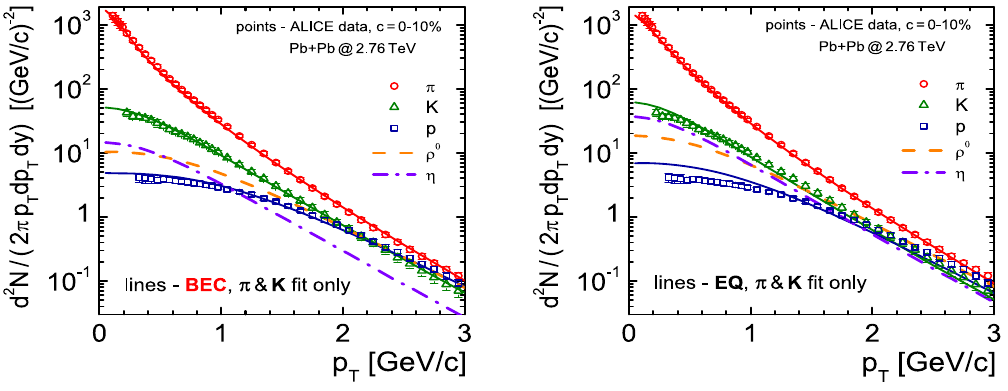
Figure 2. The fit of pions and kaons, and the prediction for protons, ρ and η in 0-10% centrality window.